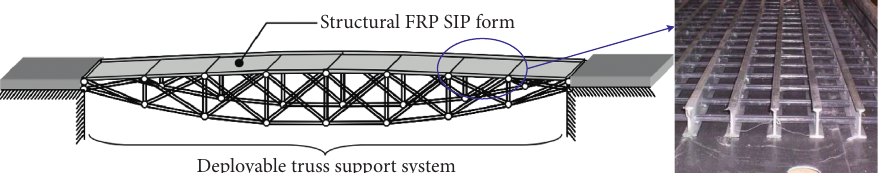
Figure 6: Construction stage of the deployable bridge.